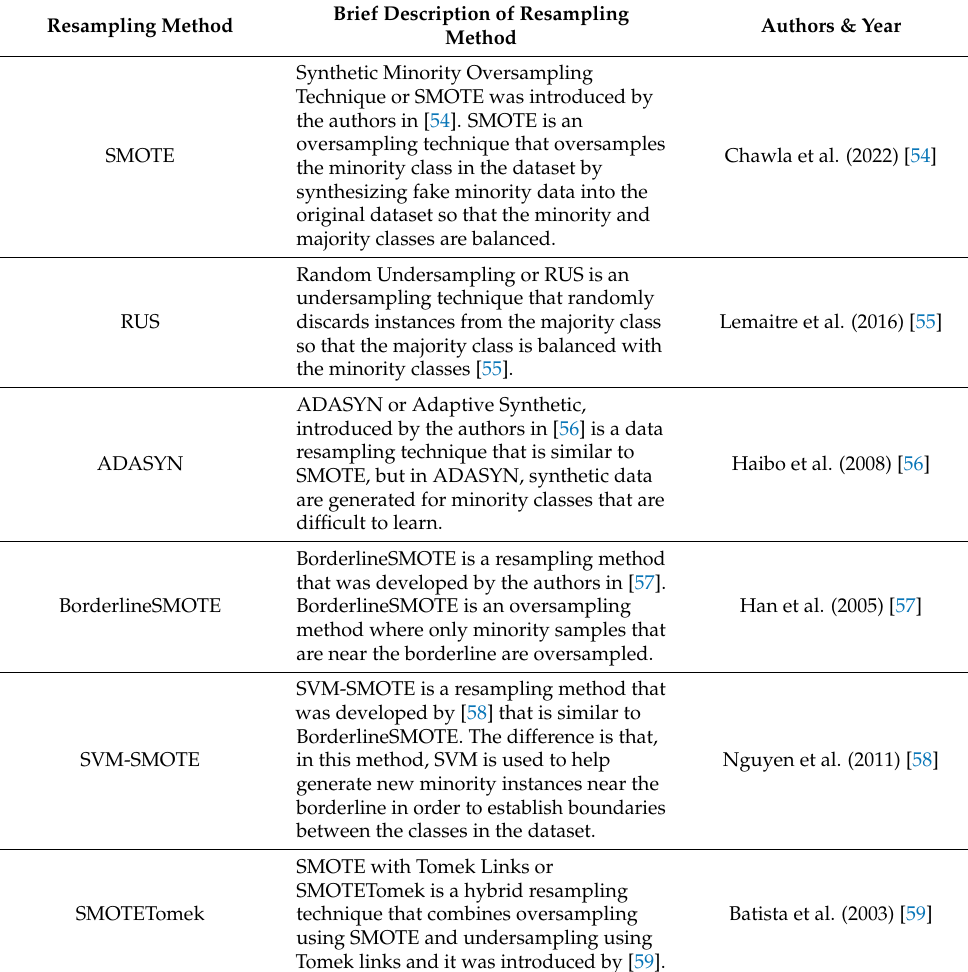
Table 8. Brief descriptions of the resampling methods used in this